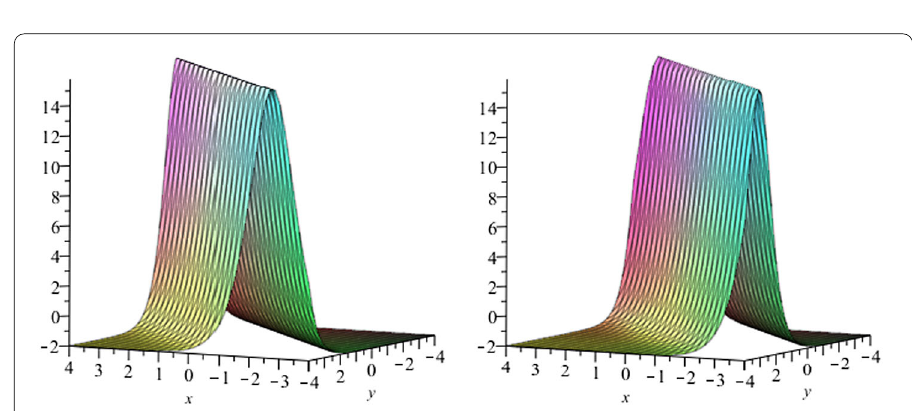
Figure 3 Solitary wave solution of real part for Eq. (4.27) with β = 0.25 and β = 0.9, respectively, when λ = –1